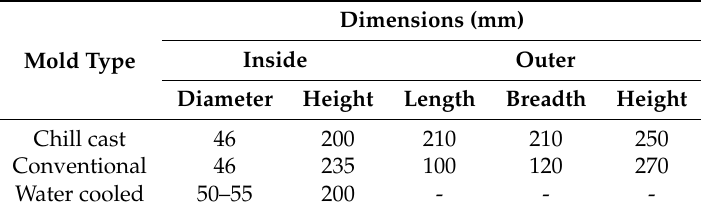
Table 1. Dimensions of the molds